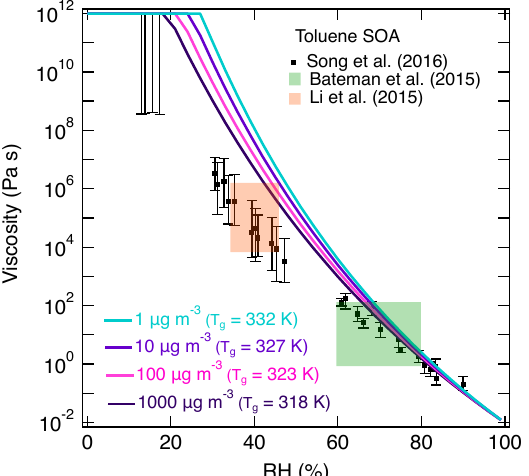
Figure A3. Effect of mass loading on predicted viscosity for toluene SOA. Solid lines represent the predicted viscosity with Eq. (2) using the chemical composition of toluene SOA formed at low RH. Viscosity was predicted with different mass loadings ranging from 1–1000µgm − 3 . Markers and shaded boxes represent experimentally measured viscosity values. The Song et al. (2016a) mass loadings were 60–100 and 600– 1000µgm − 3 . The Bateman et al. (2015) and Li et al. (2015) mass loadings were 30–50 and 44–125µgm − 3 ,